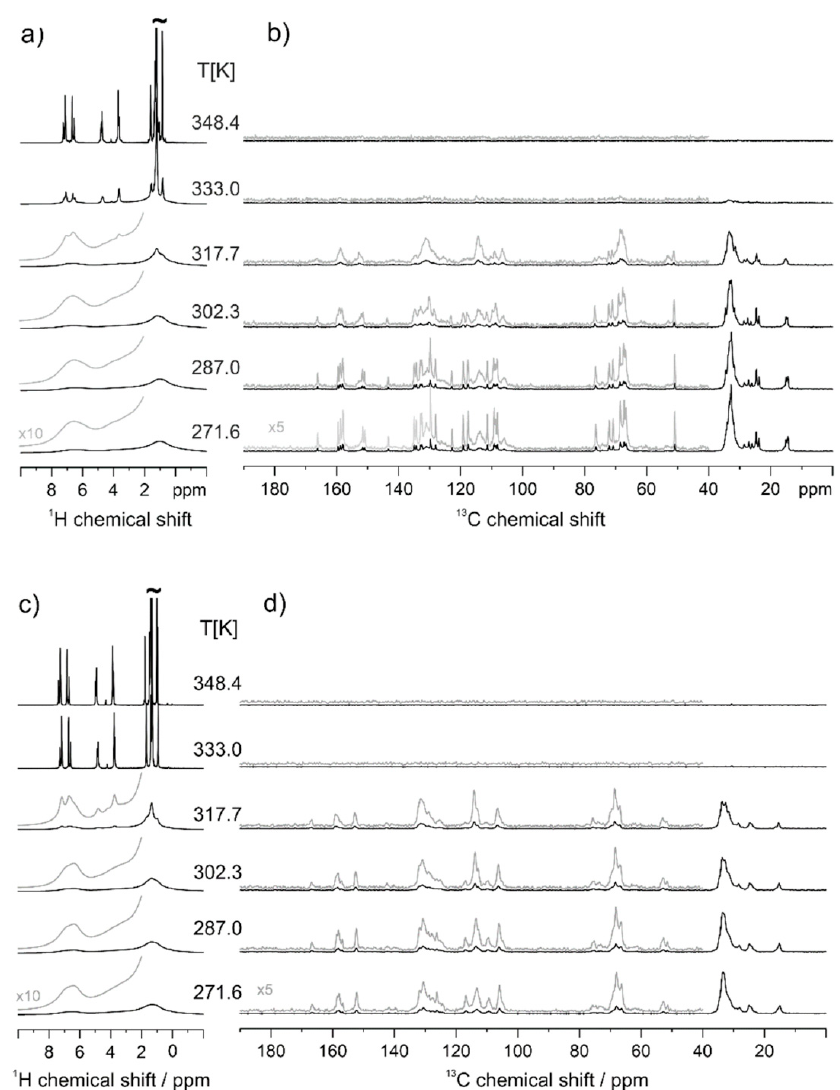
Figure 6. 1 H Magic Angle Spinning (MAS) and 13 C CP-MAS NMR spectra native PAZE100 ( a , b ) and thermal treated PAZE 100 ( c , d ) at variable temperatures. The given temperature values are corrected for the frictional heating under fast MAS conditions.